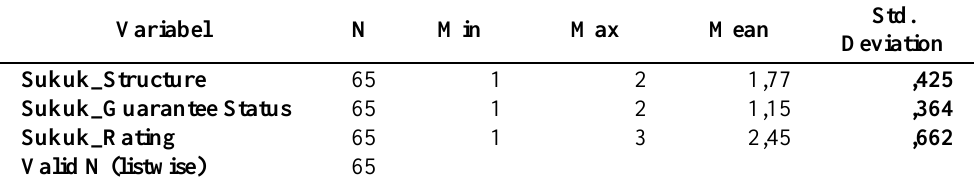
Tabel 3. Descriptive Statistical Data Analysis Results